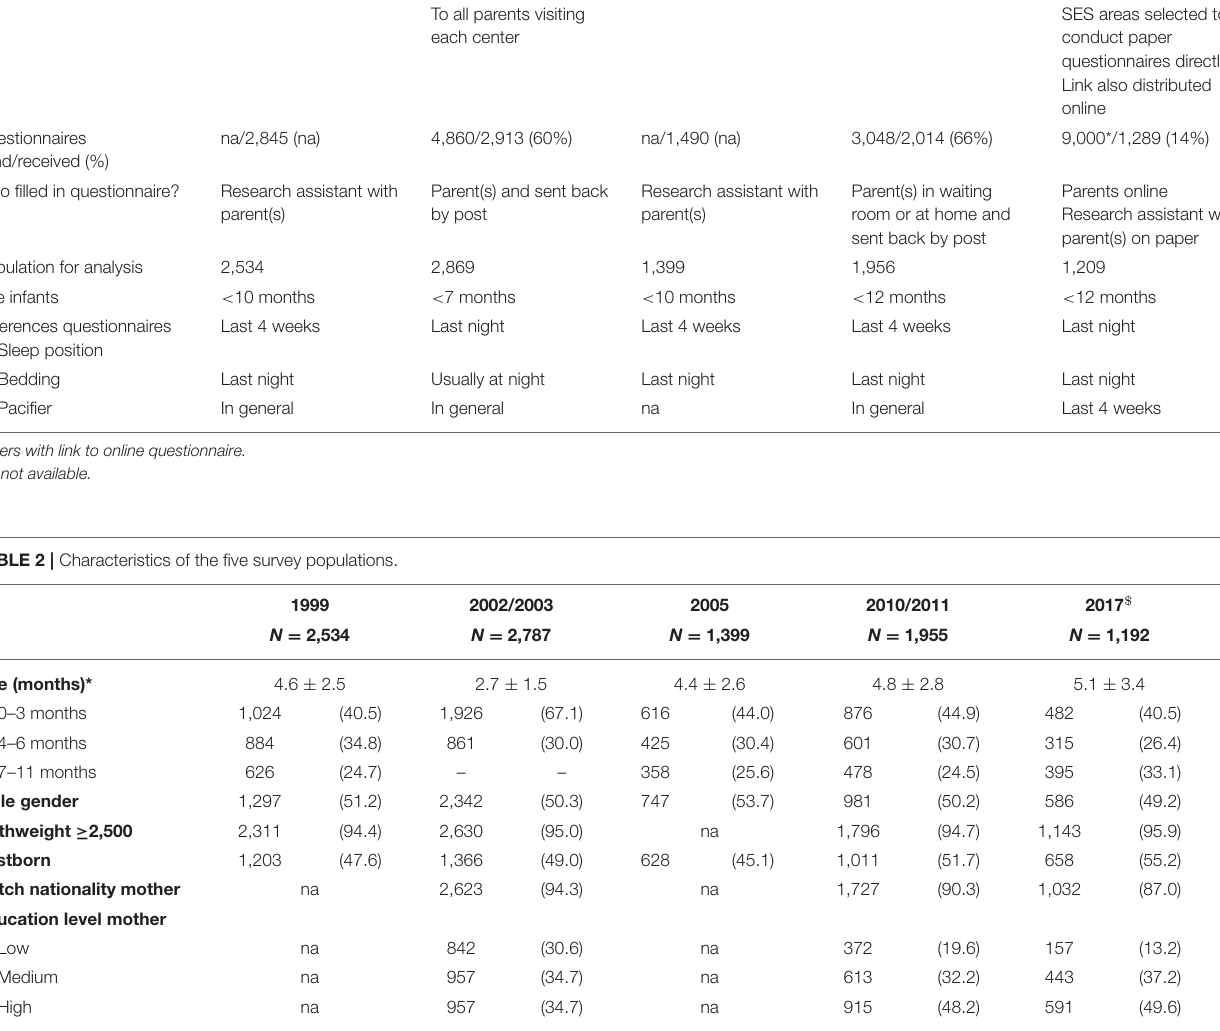
with missing data for mother’s education level were excluded. na, not available.